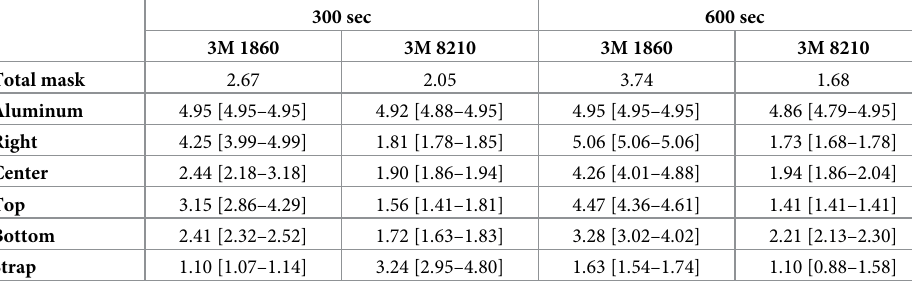
Table 1. Average log 10 reduction in viable SARS-CoV-2